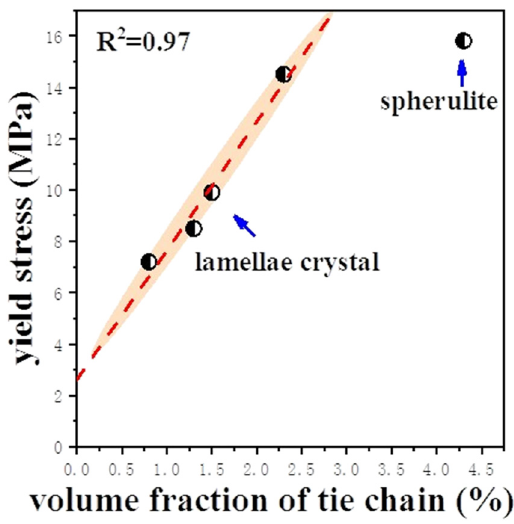
Figure 6: The relationship between yield stress and volume fraction of tie chains.